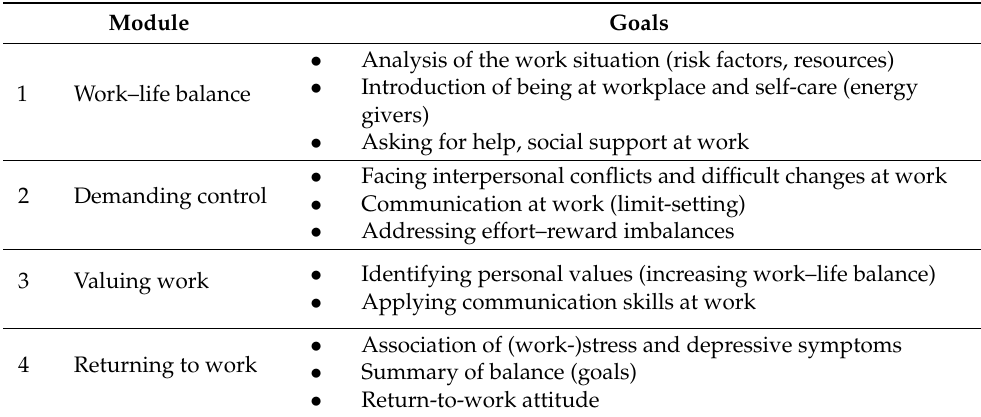
Table 1. Details of the four workplace-related interpersonal psychotherapy (W-IPT) modules. Module